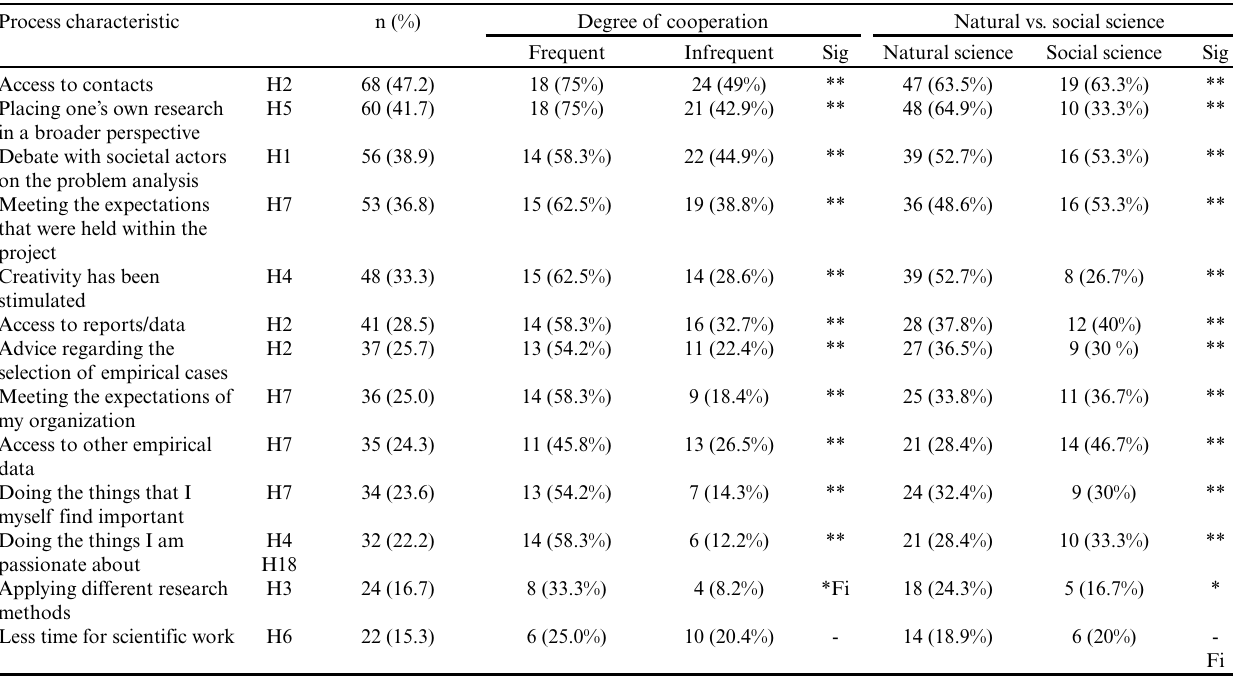
Table 5 . Changes in producing